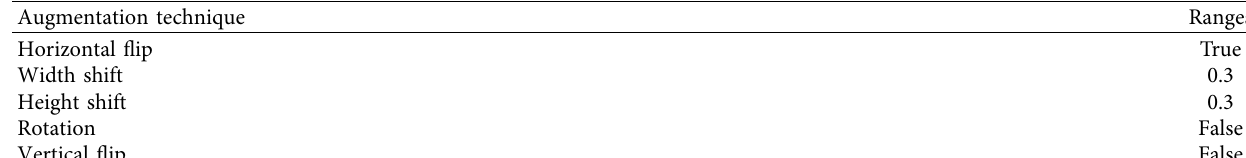
Figure 1: Proposed diagram of the system. Table 2: Data augmentation